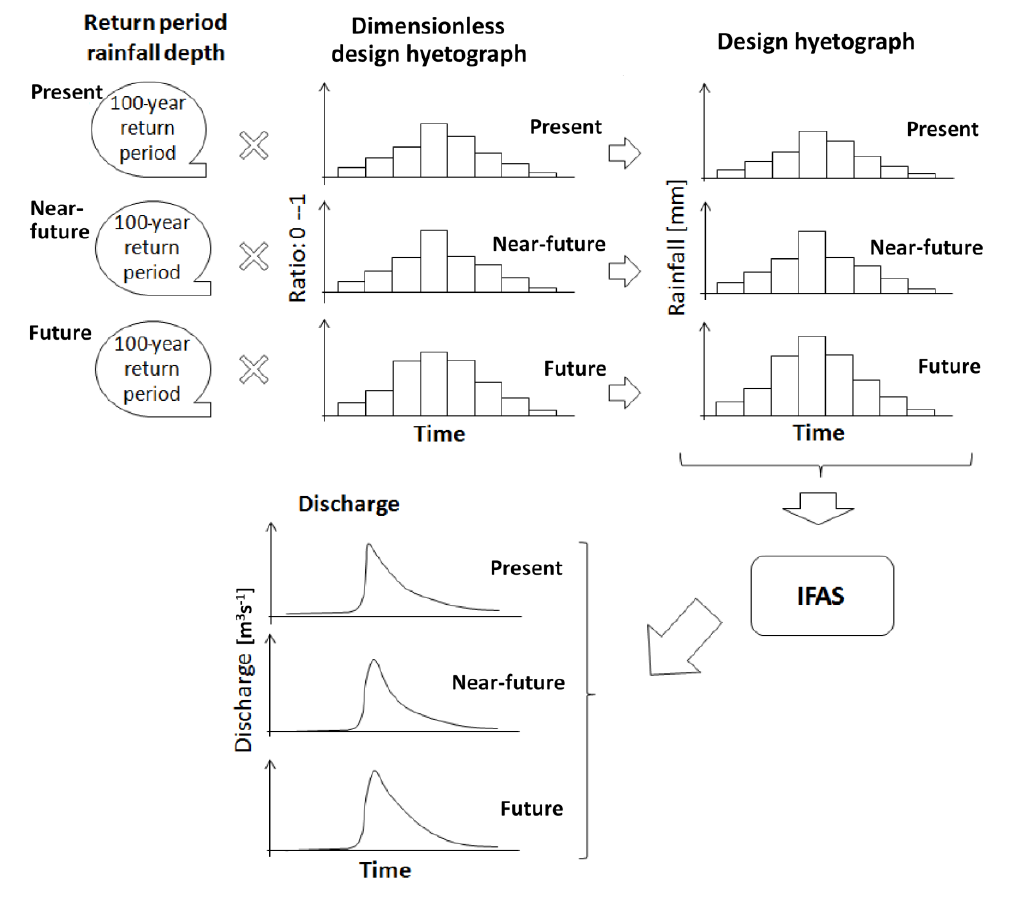
Figure 2. Process of rainfall creation and discharge simulation. Note that Integrated Flood Analysis System (IFAS) is a flood